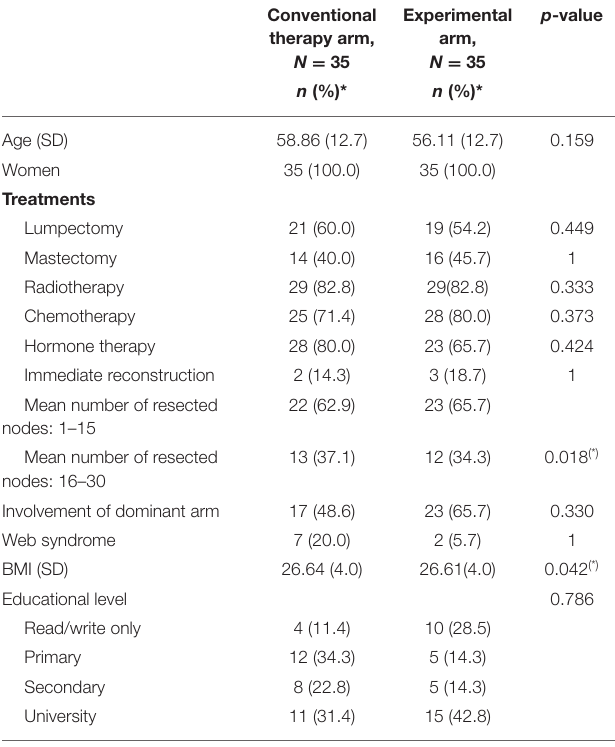
TABLE 3 | Patient sociodemographic and clinical characteristics by group. TABLE 4 | Lymphedema incidence at 2 years according to the frequency of exercises in the conventional prevention arm.